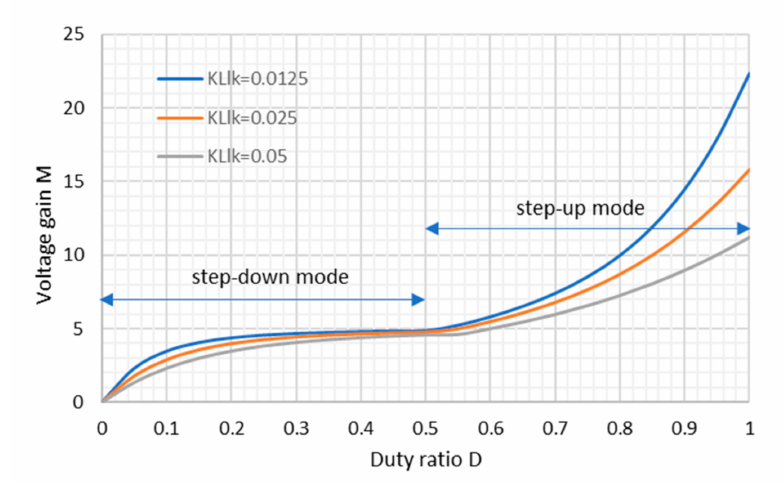
Figure 11. Voltage gain of reconfigurable topology (N =